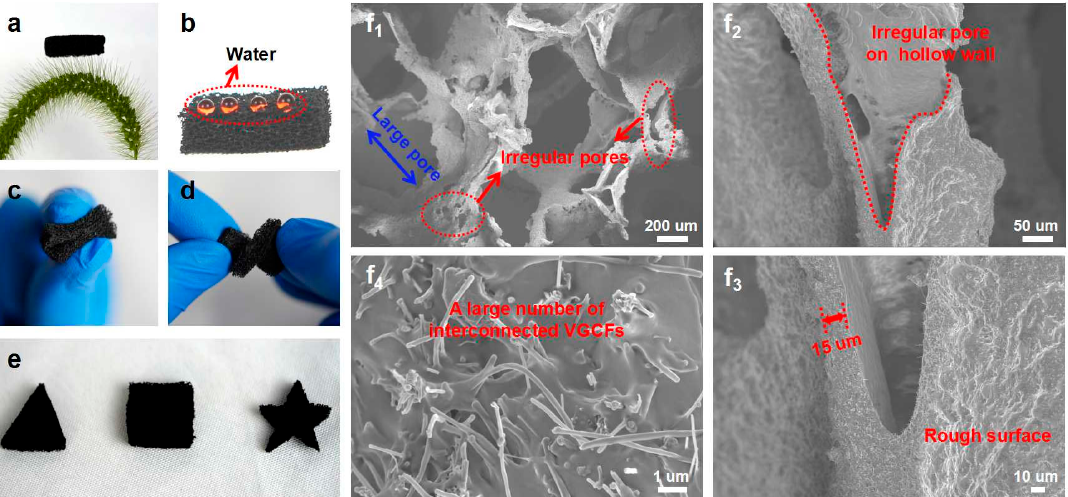
Figure 2. ( a ) Photograph of CPS standing on the bristle grass without bowing any hairy branches. ( b ) Photograph of water droplets on the surface of the VGCFs/PDMS sponge. ( c , d ) Flexibility of the CPS. ( e ) Photograph of CPS samples with different patterns. ( f 1 ) SEM images of CPS and its hollow skeleton ( f 2 , f 3 ) and the cross-section of CP wall ( f 4